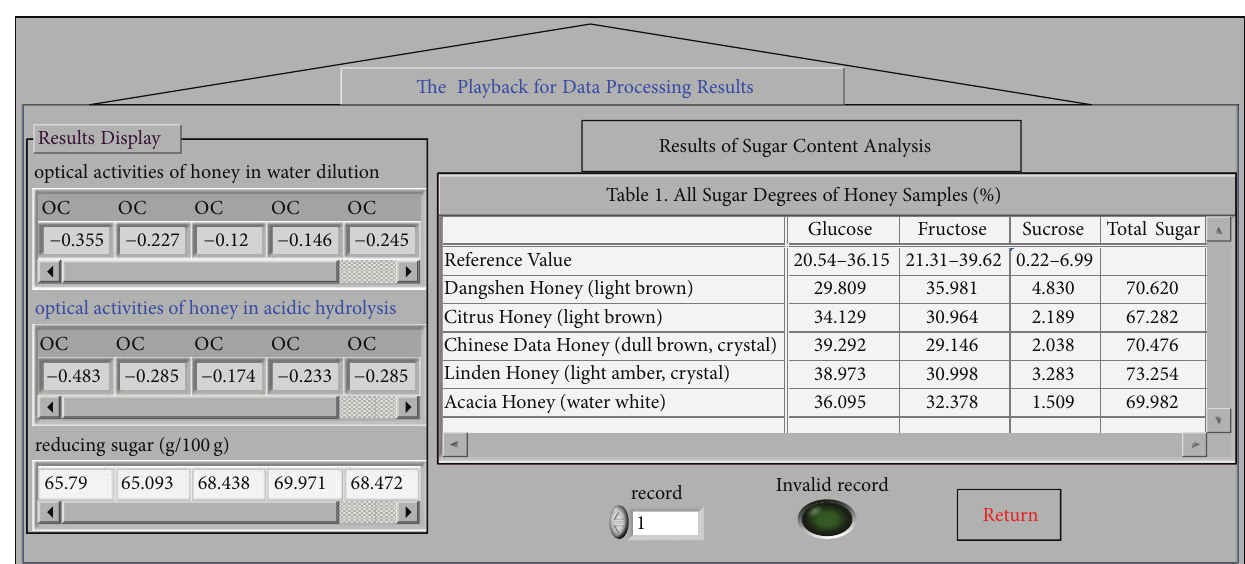
Figure 6: The playback panel for data